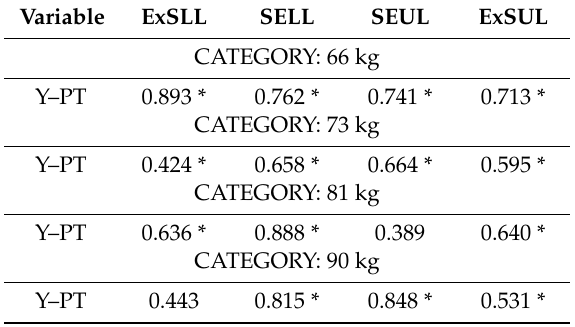
Table 2. Correlations of explosive strength with variables of strength endurance of the lower and upper limbs in weight categories of 66, 73, 81 and 90 kg and the ranking score (PJA).